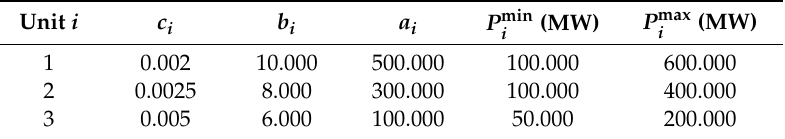
Table A1. All of the data for the three-unit system.